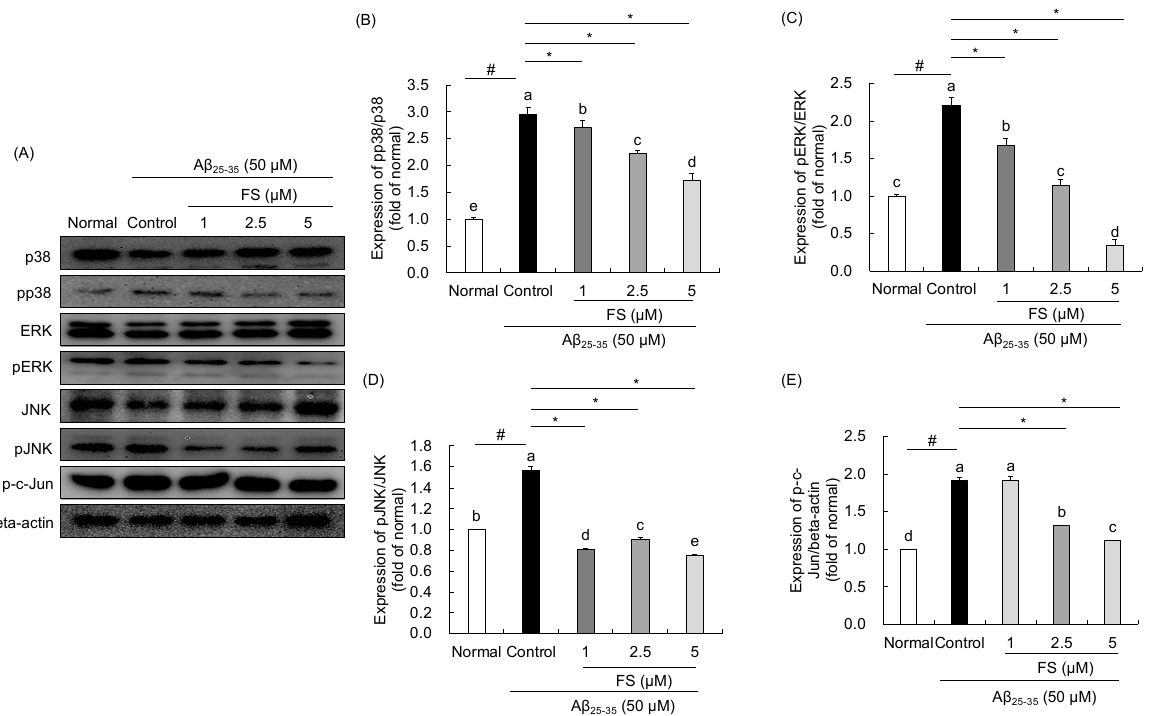
Figure 6. Effects of N -feruloyl serotonin on MAPKs signaling pathway in SH-SY5Y cells. The western blot bands ( A ), relative protein levels of pp38/p38 ( B ), pERK/ERK ( C ), pJNK/JNK ( D ), and p-c-Jun ( E ). Values present means ± SD ( n = 3). a–e Means with different letters are significantly different ( p < 0.05) by Duncan’s multiple range test. # p < 0.01 vs. normal; * p < 0.05 vs. control. FS, N -feruloyl serotonin.